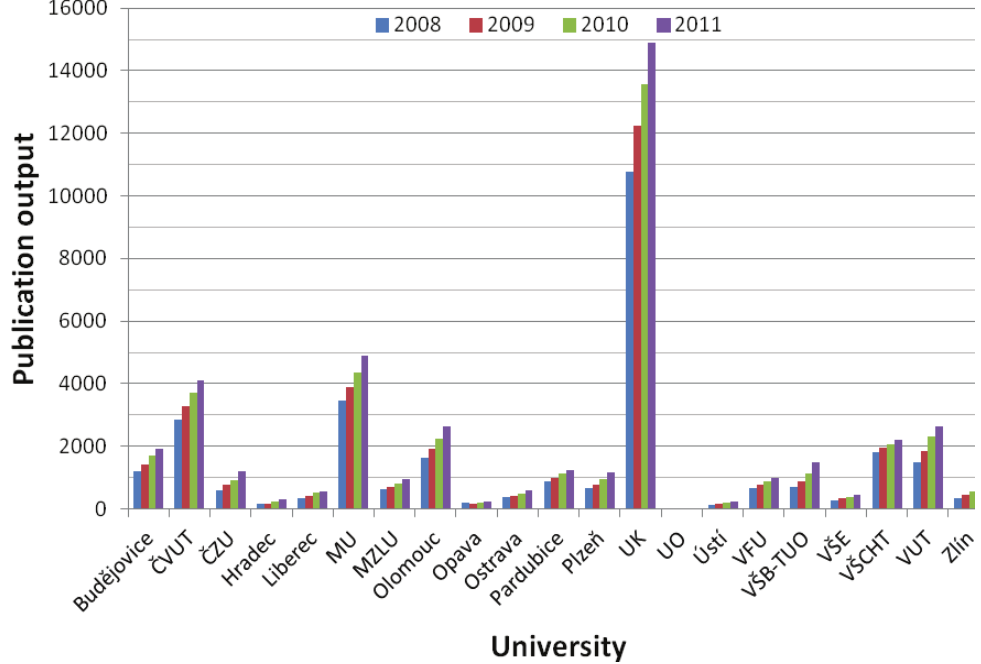
Figure 4. Absolute and relative university publication output in 2008–2011 by